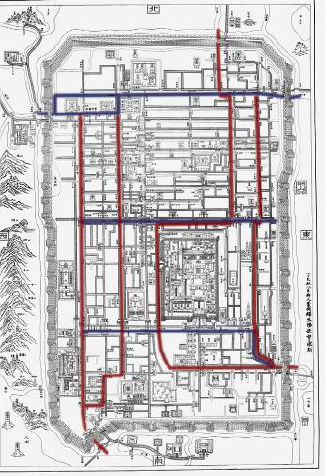
Figure 3. “ San Heng Si Zhi ” ( 三橫四直 ) 3 Latitudinal and 4 Longitudinal water courses in the Map of Pingjiang